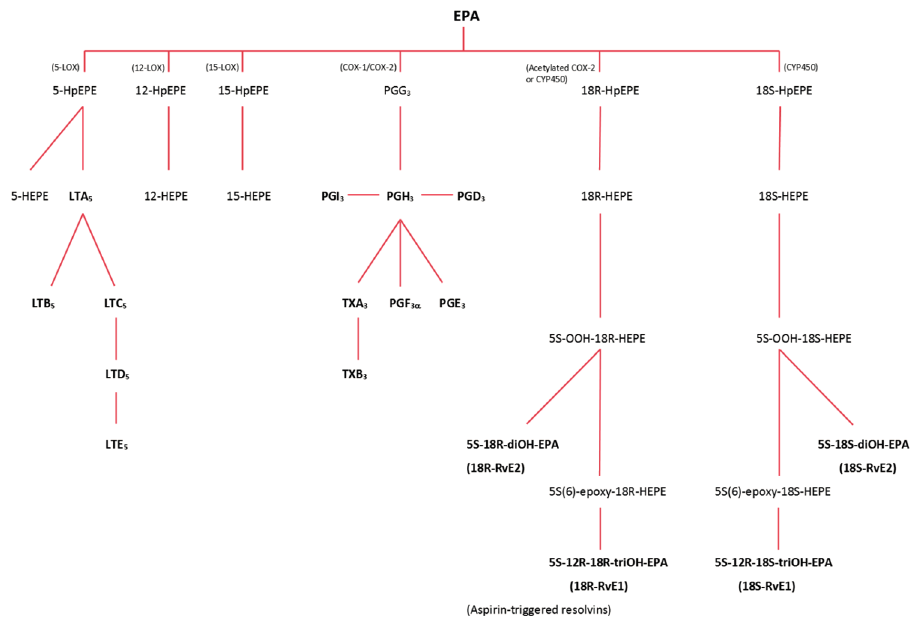
Figure 1. Overview of the pathways involved in the production of eicosanoids and specialized pro-resolving mediators from eicosapentaenoic acid (EPA). The figure is adapted from [16,17]. Products derived through the lipoxygenase (LOX) pathway are 5-, 12- and 15-HEPE, along with the leukotrienes A to E (LTA, LTB, LTC, LTD and LTE). Through the cyclooxygenase (COX) pathway, the prostaglandins D to I (PGD, PGE, PGF, PGG, PGH and PGI) and thromboxanes A and B (TXA and TXB) are produced. Aspirin-acetylated COX-2 catalyzes the production of aspirin-triggered resolvins E1 (18 R -Rv1) and E2 (18 R -Rv2), while the regular resolvins E1 (18 S -Rv1) and E2 (18 S -Rv2) are catalyzed by cytochrome P-450 (CYP-450). HpEPE: hydroperoxyeicosapentaenoic acids; HEPE: hydroxyeicosapentaenoic